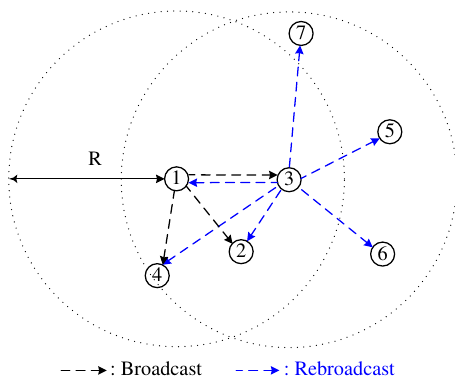
Figure 2. Neighborhood-aware counter-based broadcast scheme.